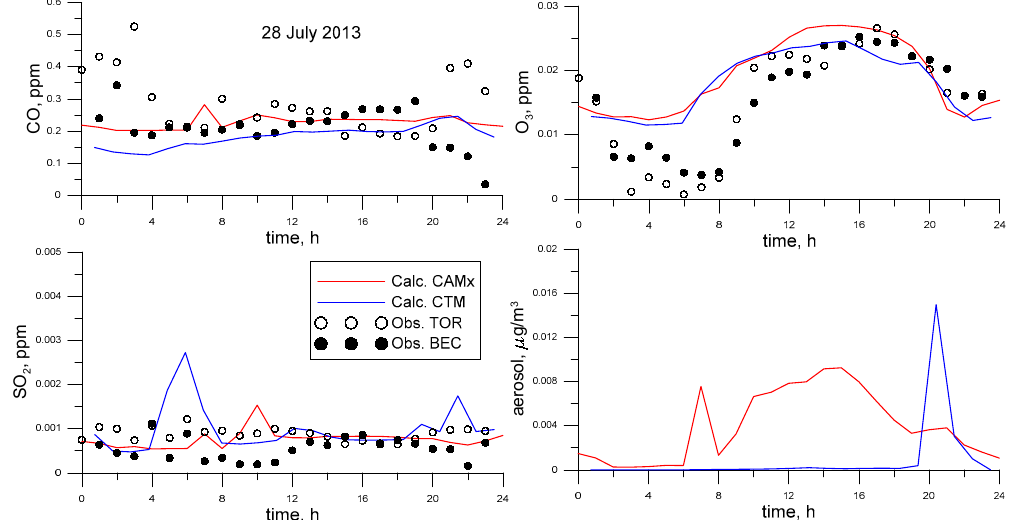
Figure 2. Calculated and measured near ground meteorological values at the observation sites. The blue lines are the results of numerical prediction at the TOR station and symbols are observation data (open circles—TOR, closed circles—BEC, triangles—GMC).